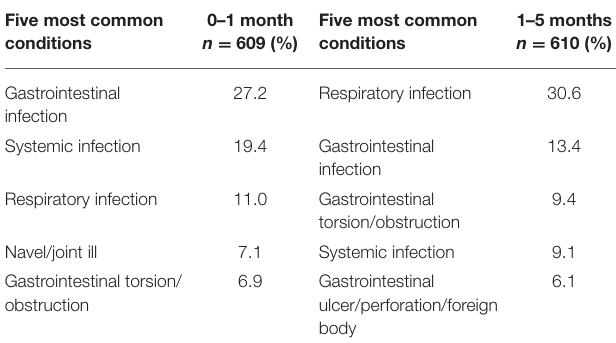
TABLE 2 | Conditions most frequently diagnosed on post-mortem examinations of calves (0–5 months old) which died on Irish farms, ( n = 1,219) (117). Five most common